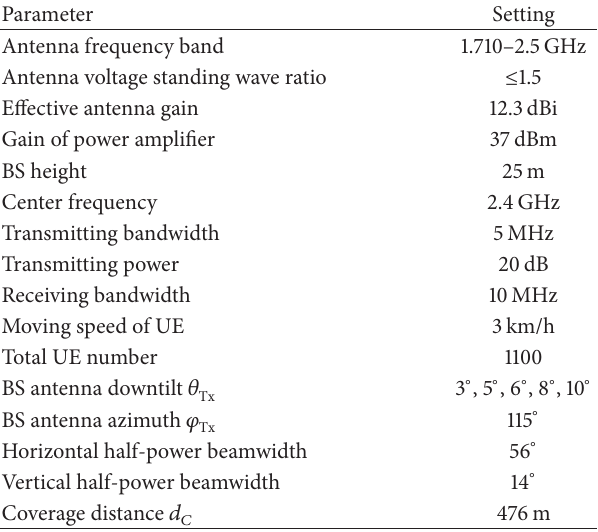
Table 2: Parameter settings used in the